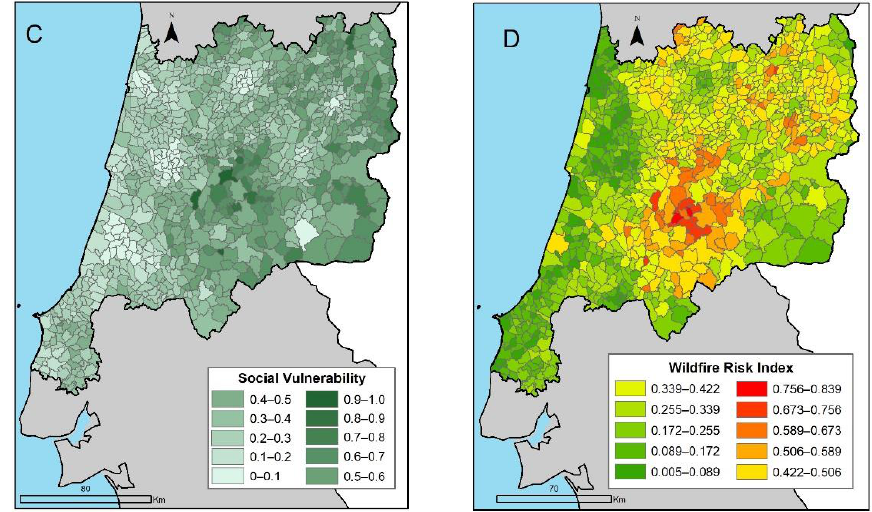
Figure 10. The three wildfire risk dimensions and the final wildfire risk index: ( A ) hazard, ( B ) exposure, ( C ) social vulnerability; ( D ) wildfire risk. All values were rescaled to values between 0 and 1 using the min-max technique. Maps were classified using equal intervals.